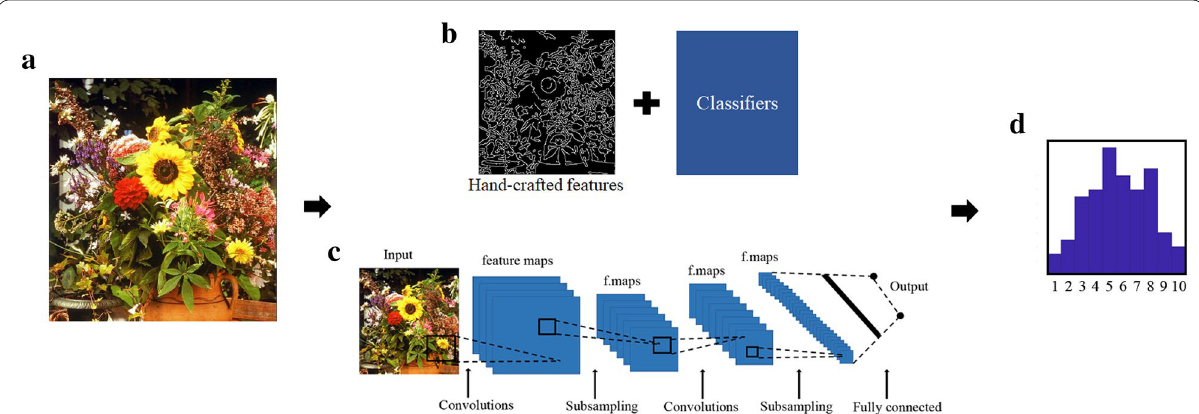
Fig. 3 A workflow for image quality assessment. a The original image. b Hand-crafted features are extracted by computational algorithms and subsequently feed to classical classifiers. c Using neural network to automatically extract image features related to aesthetic ratings. d Final